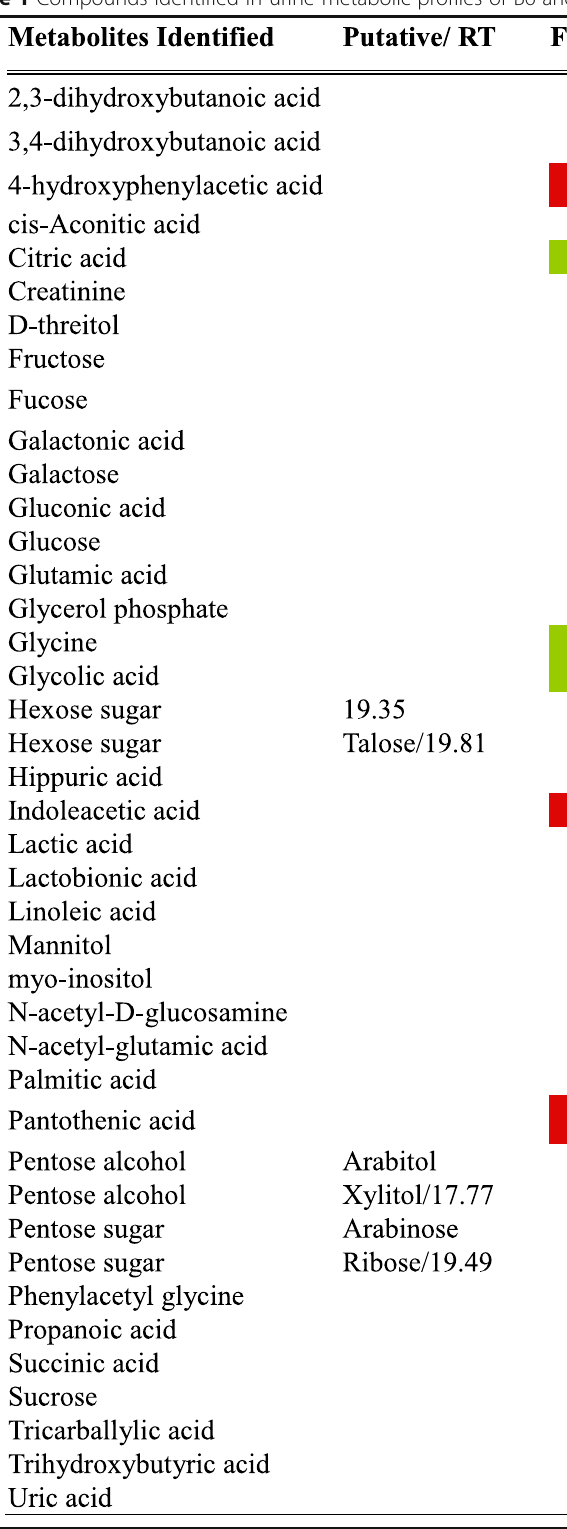
Table 1 Compounds identified in urine metabolic profiles of B6 and pIgR − / − male & female